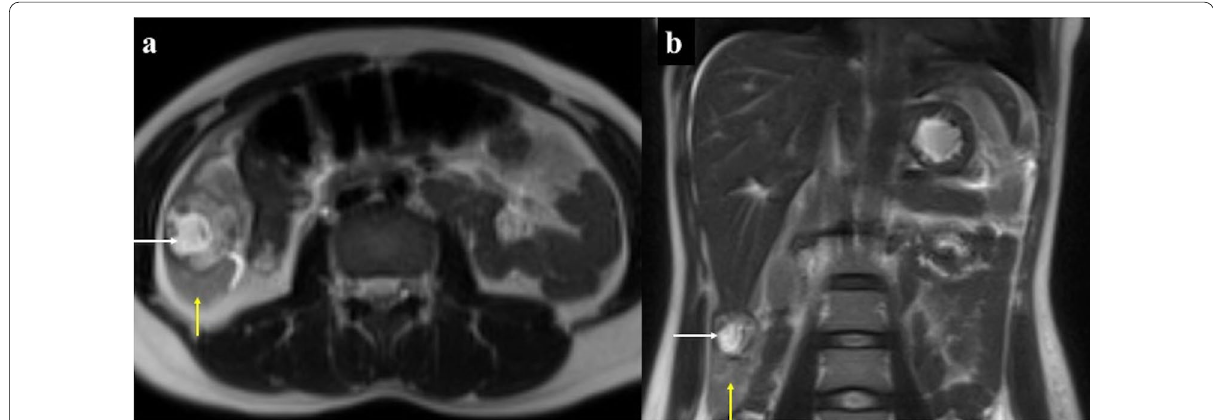
Fig. 2 ( a - b ) Axial and coronal T2-weighted magnetic resonance images showing gestational sac (white arrows) is attached to the inferior surface of Segment VI of liver with surrounding mildly T2 hyperintense peri-gestational hematoma (yellow arrows)